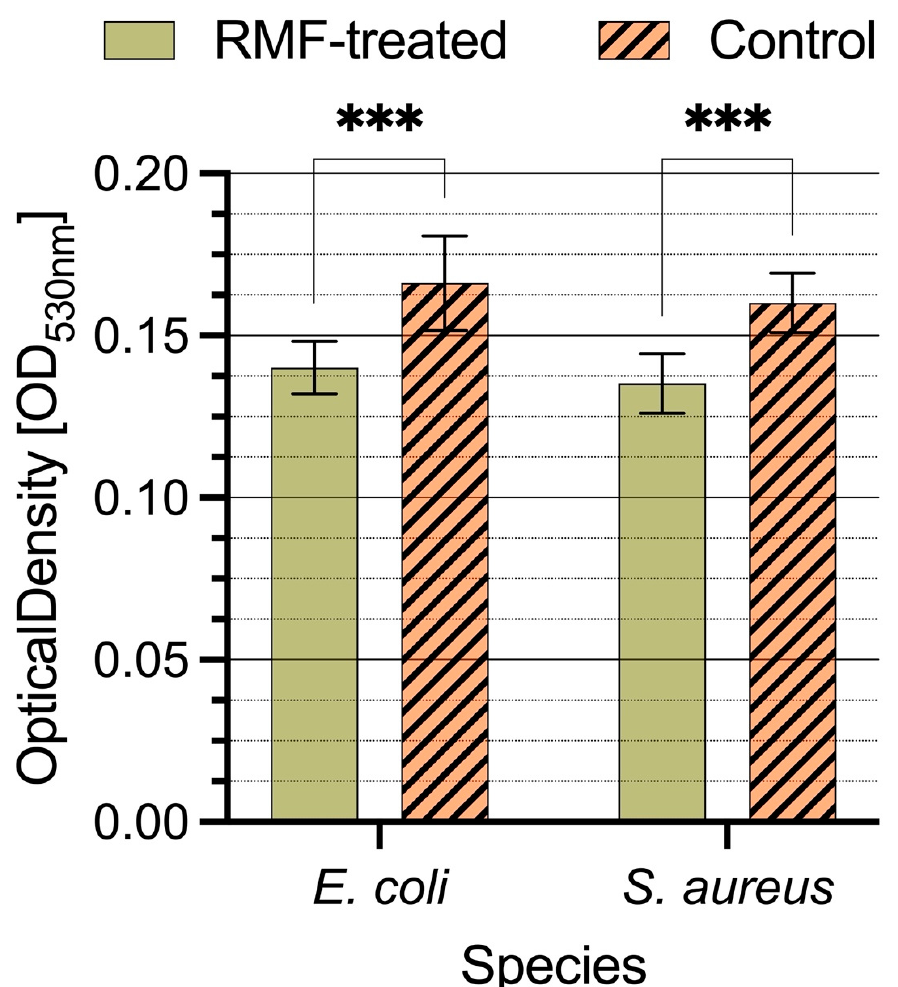
Figure 3. Influence of the RMF exposition on Cytochrome C binding to the bacterial cell surface. *** indicate statistically significant values.